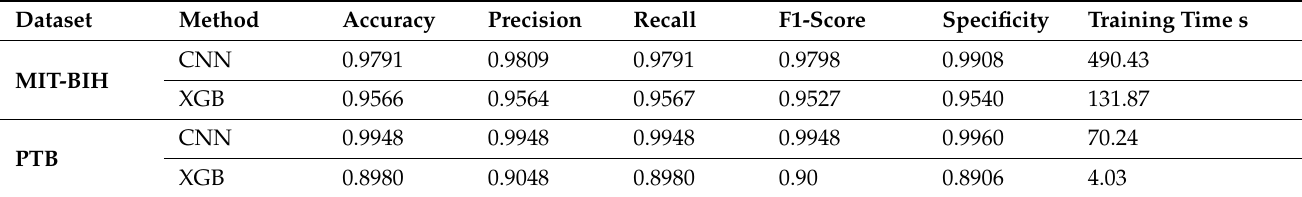
Table 5. Performance results for CNN and XGBoost models.